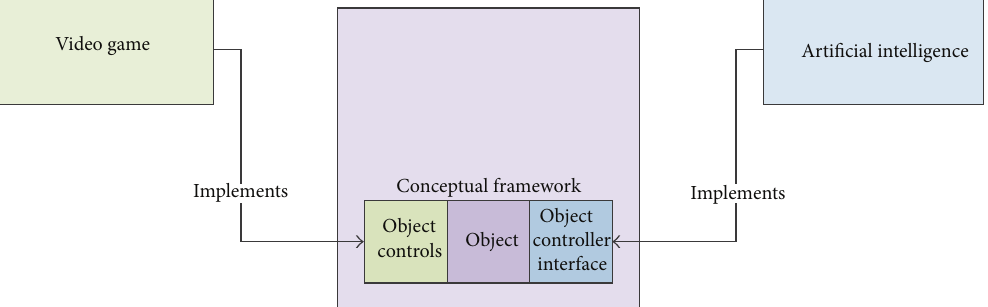
Figure 8: Conceptual controls and controller interface. Both are defined by the CF developers. Conceptual controls have to be implemented by game developers while the controller interface has to be implemented by AI developers.